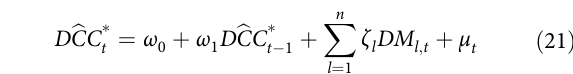
Table 7 Empirical results of four speci fi cations for DCC models.